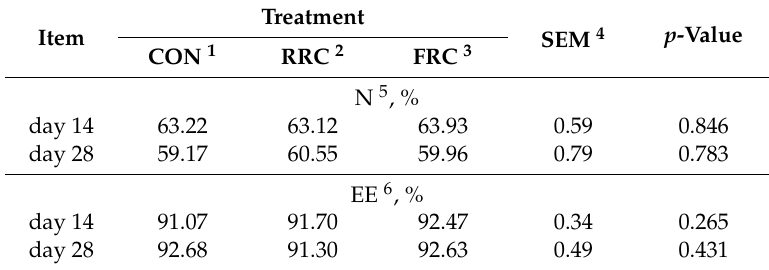
Table 5. E ff ects of use of raw or fermented rapeseed cake on the coe ffi cients of total tract apparent digestibility of ether extract and nitrogen retention in broiler chickens; experiment 1.